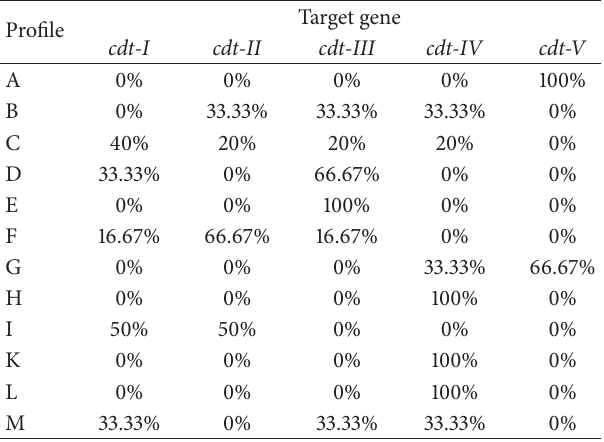
Table 5: The frequency of different cdt -types based on virulent plasmid-borne genes in isolates